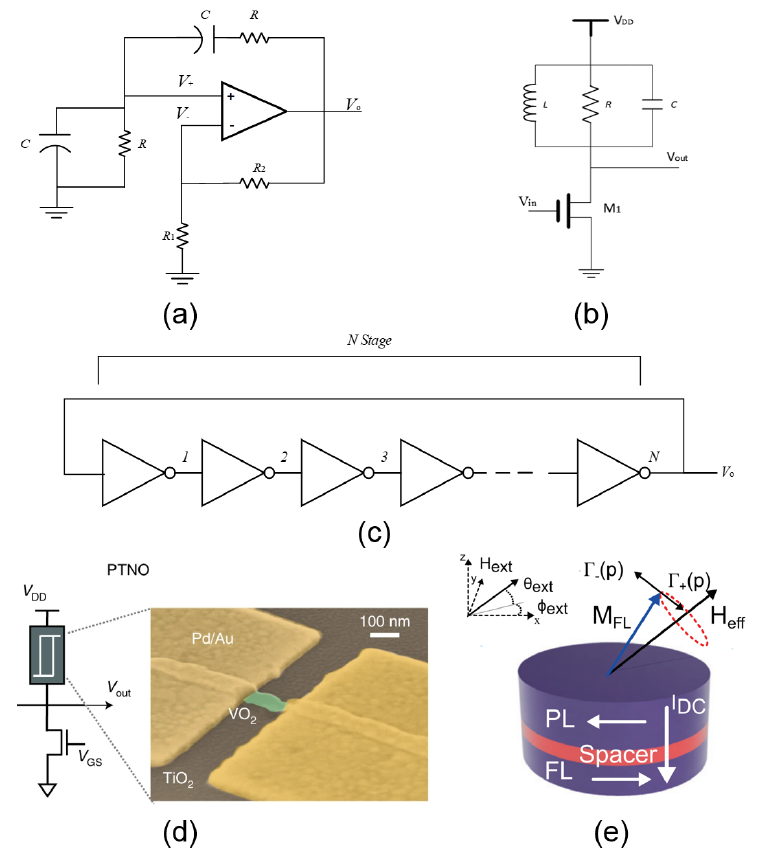
Figure 3. Schematic diagram of ( a ) RC oscillator; ( b ) LC oscillator; ( c ) ring oscillator; ( d ) phase-transition oscillator [22]; ( e ) spintronic oscillator [24].